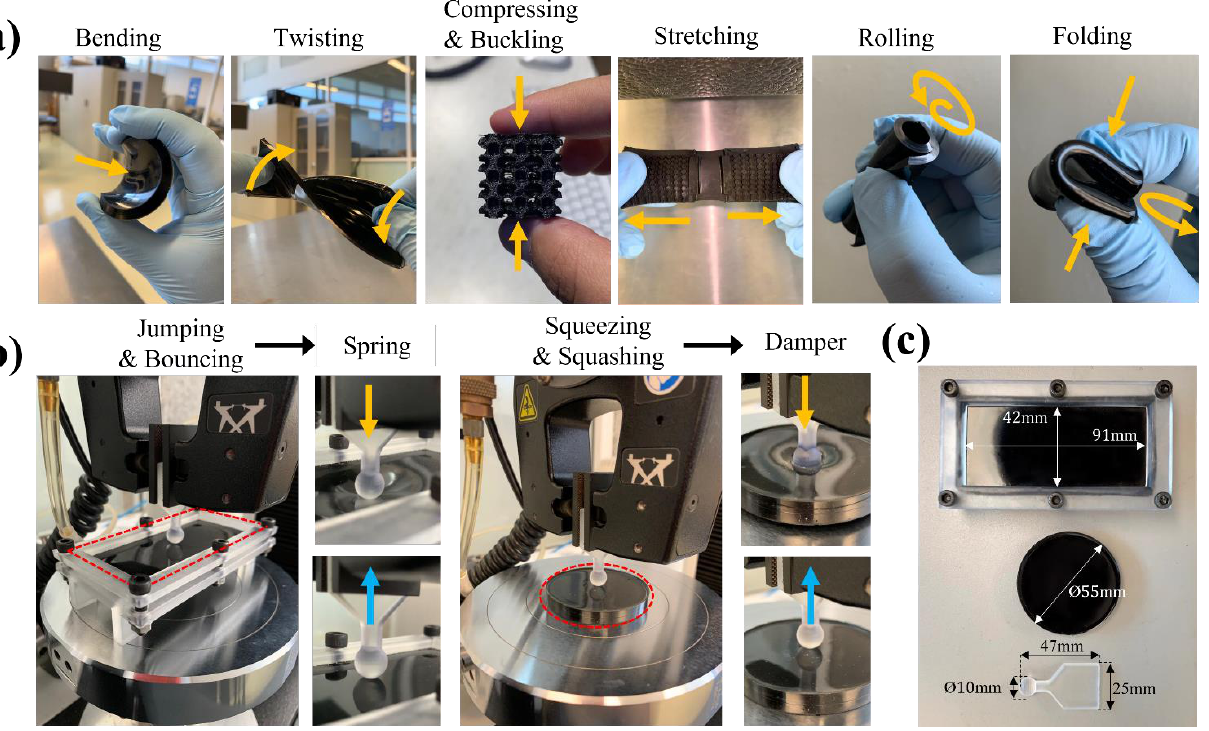
Figure 4. ( a ) Traditional in-plane deformation mechanisms for continuous or architected flexible materials; ( b ) deformation mechanisms inspired by out-of-plane indentation with unconventional boundary conditions that reveal elastic performance similar to spring or damper behavior descriptors; ( c ) custom-made fixture and indentation tip for out-of-plane deformation testing.